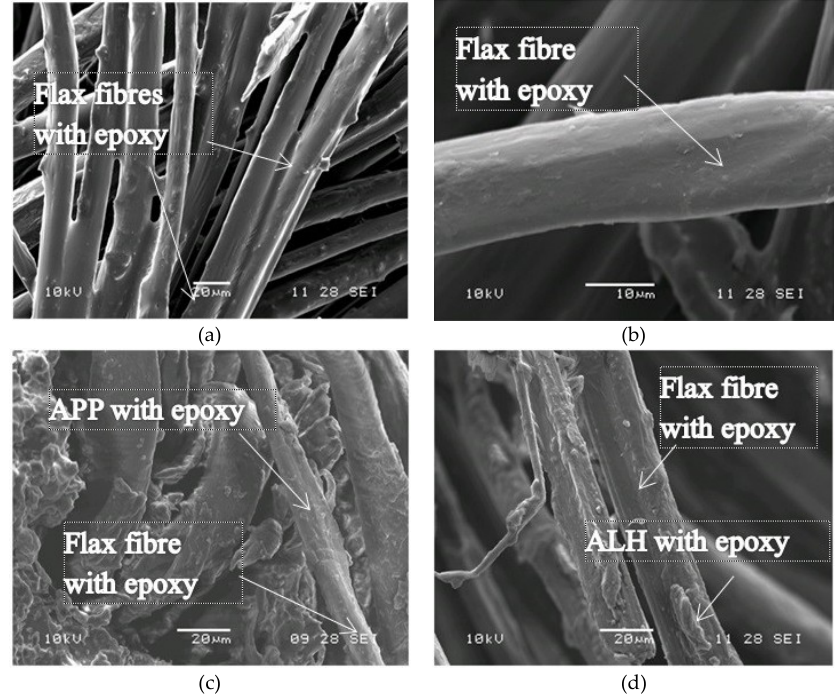
Figure 5. FFRP morphology using SEM: (a, b) 2L-FFRP (c) 2L-FFRP-APP30%; (d)